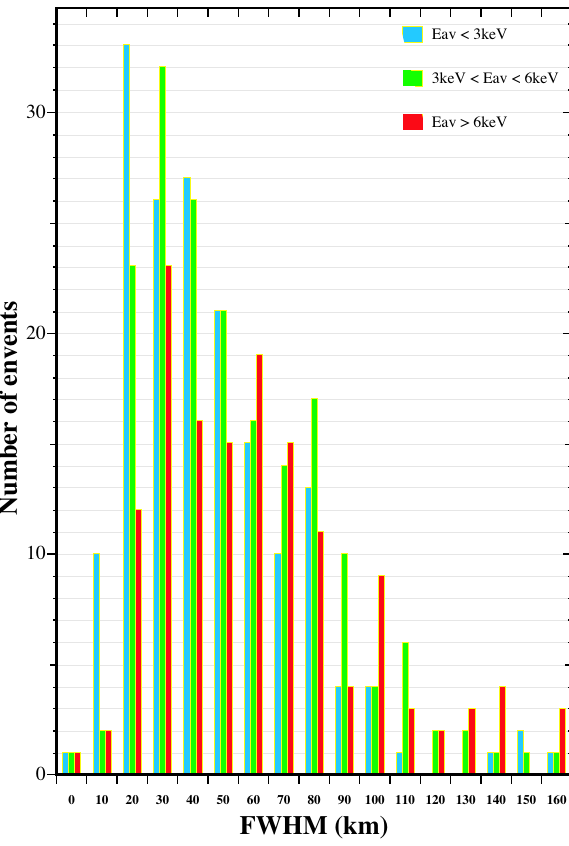
Fig. 10. Distribution of Kp index during the inverted-V’s for events with peak energies of less than 3 keV (blue), between 3 and 6 keV (green), and more than 6 keV (red).